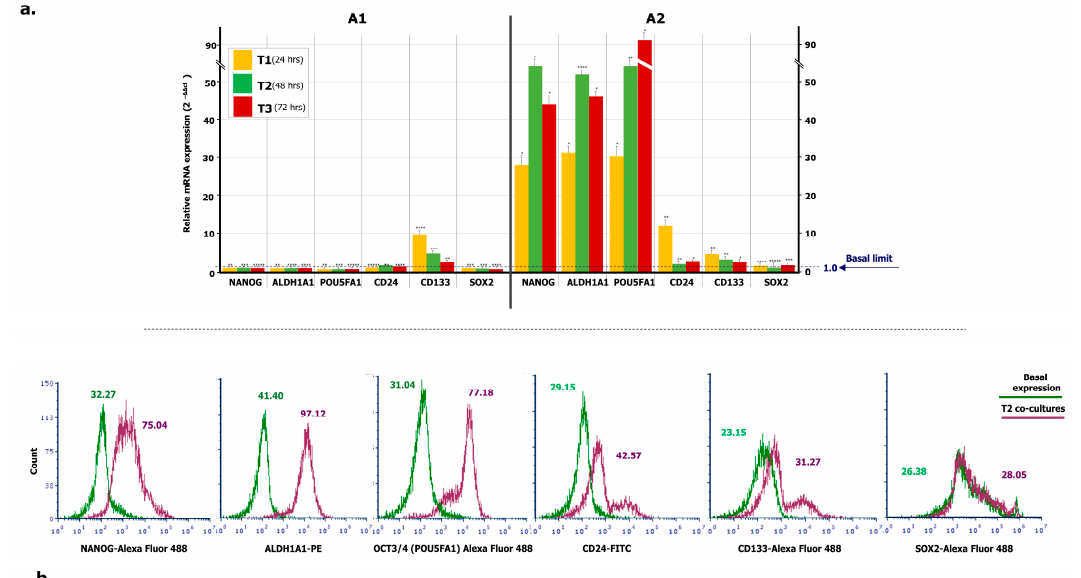
Figure 4 Figure 4. Expression of stemness markers in A2780 population conditioned by OC-derived ML-Ddx4